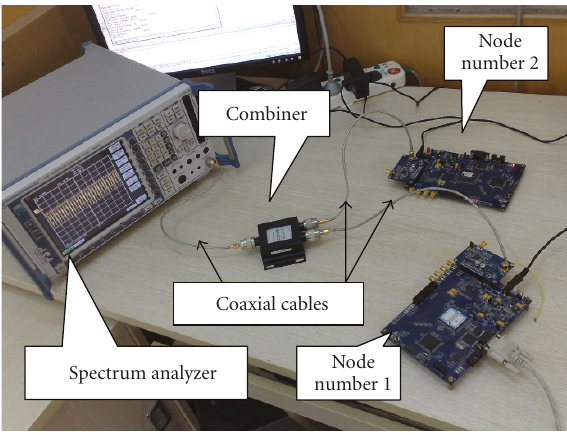
Figure 7: Experiment setup of the test platform.